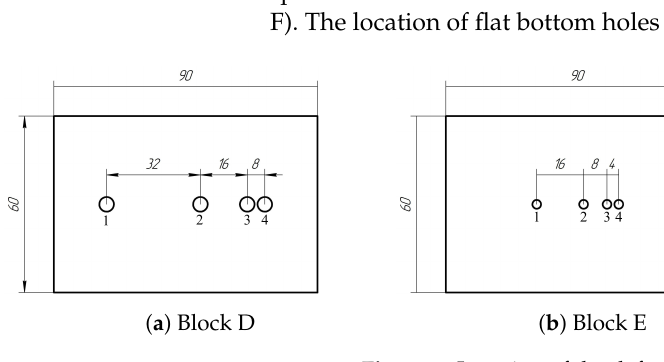
Figure 8. Location of the defects in steel blocks.